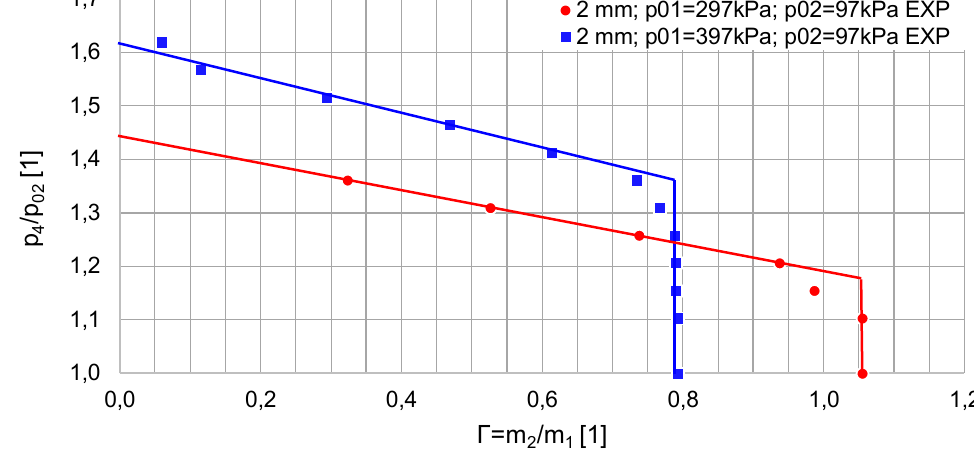
Fig. 9. Characteristics of the ejector